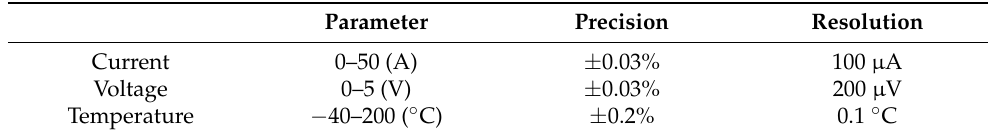
Table 3. Specifications of each channel of the battery